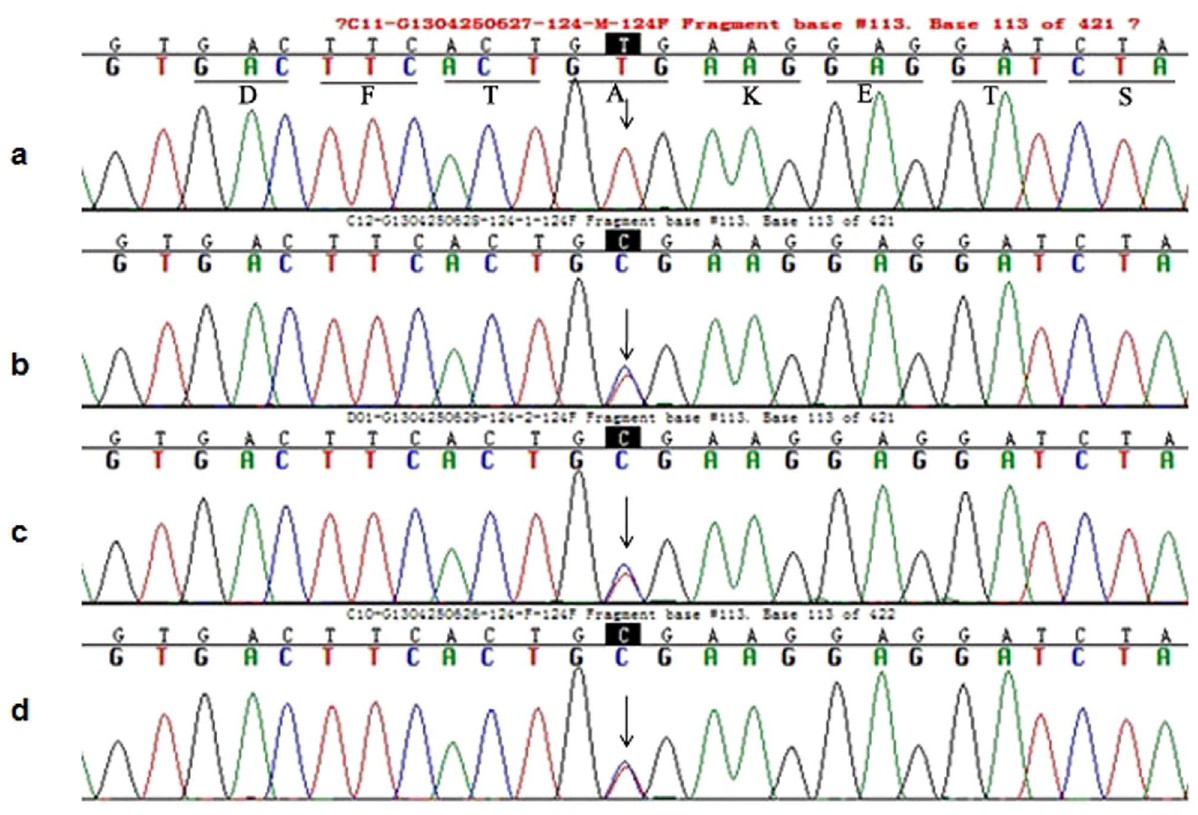
Figure 2. Partial sequence of exon 24 in the PKHD1 from member of this Caroli disease-affected pedigree. (b), (c) and (d) Arrowhead indicates the heterozygous T and C at nucleotide 2507 in proband, elder twins and their father respectively. (a) Arrowhead indicates the T at nucleotide 2507 (wild type) in their mother.